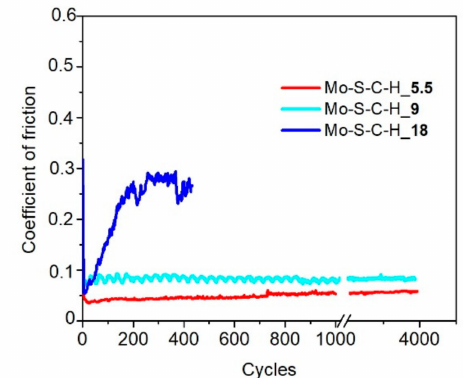
Figure 10. Characteristic evolution of the friction coefficient as a function of the cycle number for the Mo-S-C-H thin-film coatings obtained by reactive PLD at the pressures of H 2 S gas of 5.5, 9, and 18 Pa.